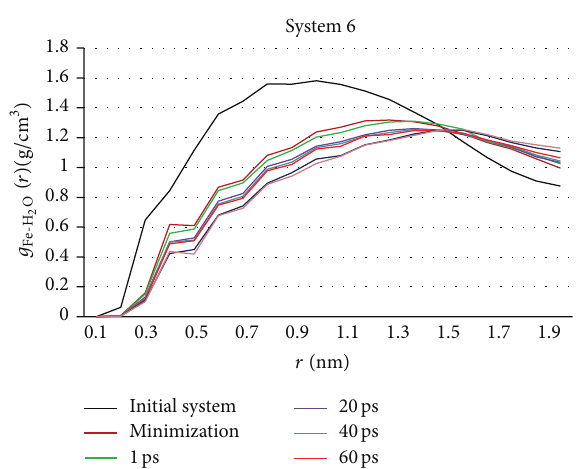
Figure 16: RDF curves of Fe-H 2 O of system 6 in key